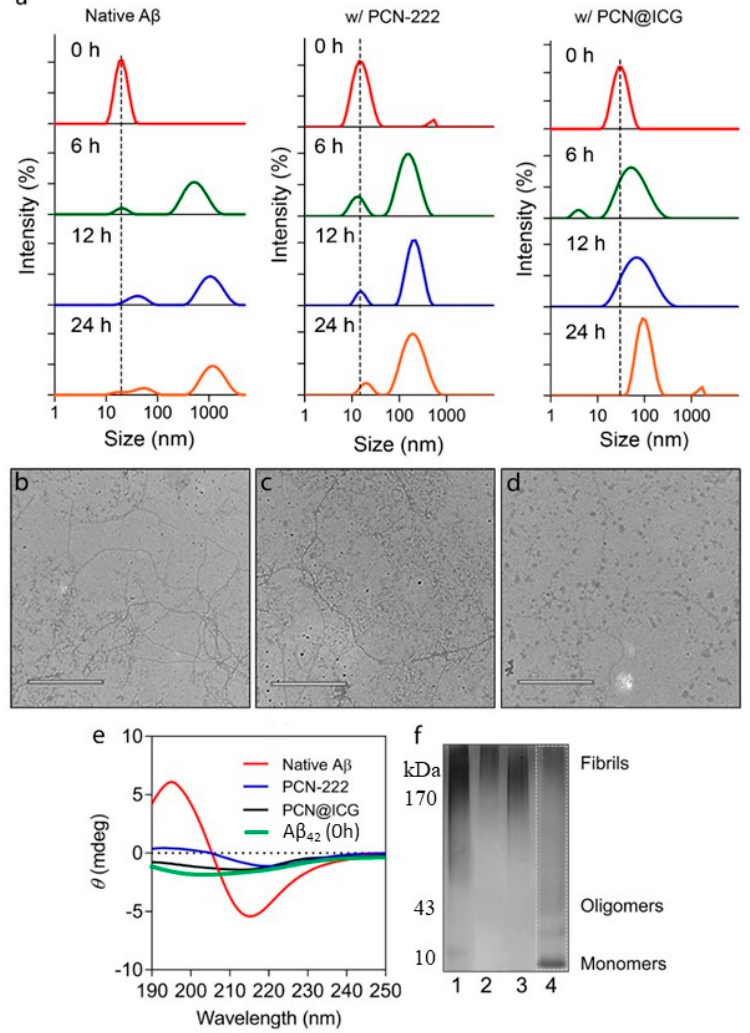
Figure 4. Inhibition effect on A β 42 aggregation by photo-activated PCN − 222 and PCN − 222@ICG nanoprobes. ( a ) DLS analysis of sample size change at four time points of incubation (0 h, 6 h, 12 h, and 24 h) for A β 42 samples without treatment, in the presence of photo-activated PCN − 222, and in the presence of photo-activated PCN − 222@ICG; TEM images of samples after 24 h of incubation ( b ) for native A β 42 without any treatment, ( c ) in the presence of photo-activated PCN − 222, and ( d ) in the presence of photo-activated PCN − 222@ICG. ( e ) Circular dichroism analysis of native A β 42 , and A β 42 with treatments of nanoprobes under NIR irradiation. ( f ) Native PAGE of A β 42 . 1: native A β 42 ; 2: A β 42 with PCN − 222 under NIR irradiation; 3: A β 42 with PCN − 222@ICG without NIR irradiation; 4: A β 42 with PCN − 222@ICG under NIR irradiation. (The above experiments are under NIR irradiation with 0.025 mg mL − 1 , at 0.6 W cm − 2 , for 30 min.) The scale bars for TEM images are 500 nm.